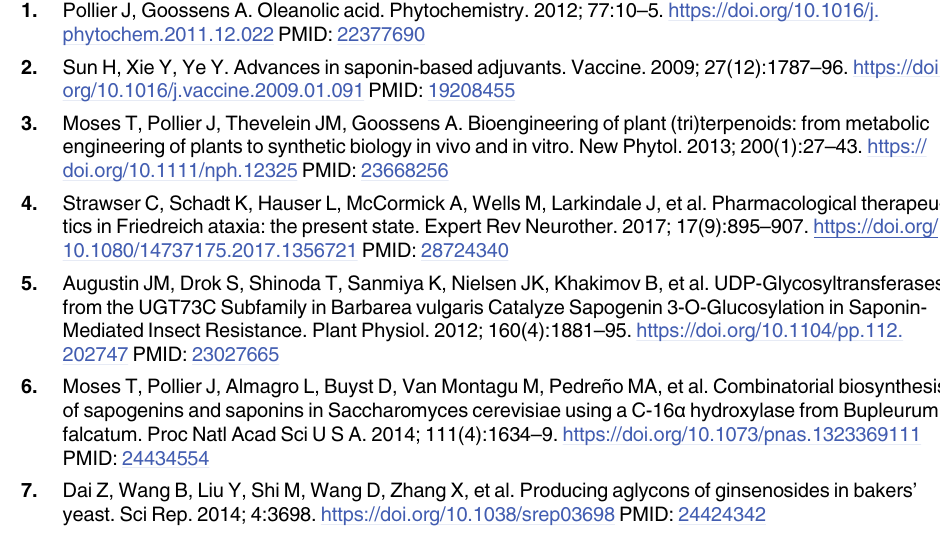
(expressing no BAS). While both AaBAS and BvBAS have a peak corresponding to β -amyrin, the BvBAS strain has a second unique peak ( � ) that is potentially a combination of two peaks and which is not present in either the AaBAS or control strains. (B) Mass spectrum at retention time marked by asterix ( � ) (top). Comparison with a mass spectrum of an authentic lupeol standard (bottom) suggests one of the compounds contained within the peak corresponds to lupeol. S1 Table. List of